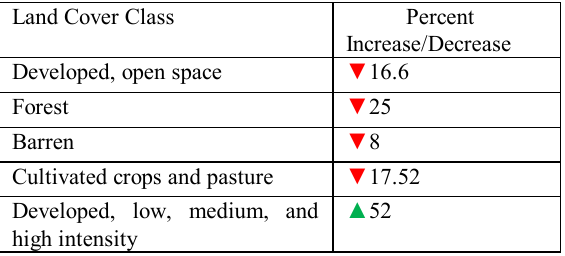
Table 1 . Percent Land Cover Change from 2001 through